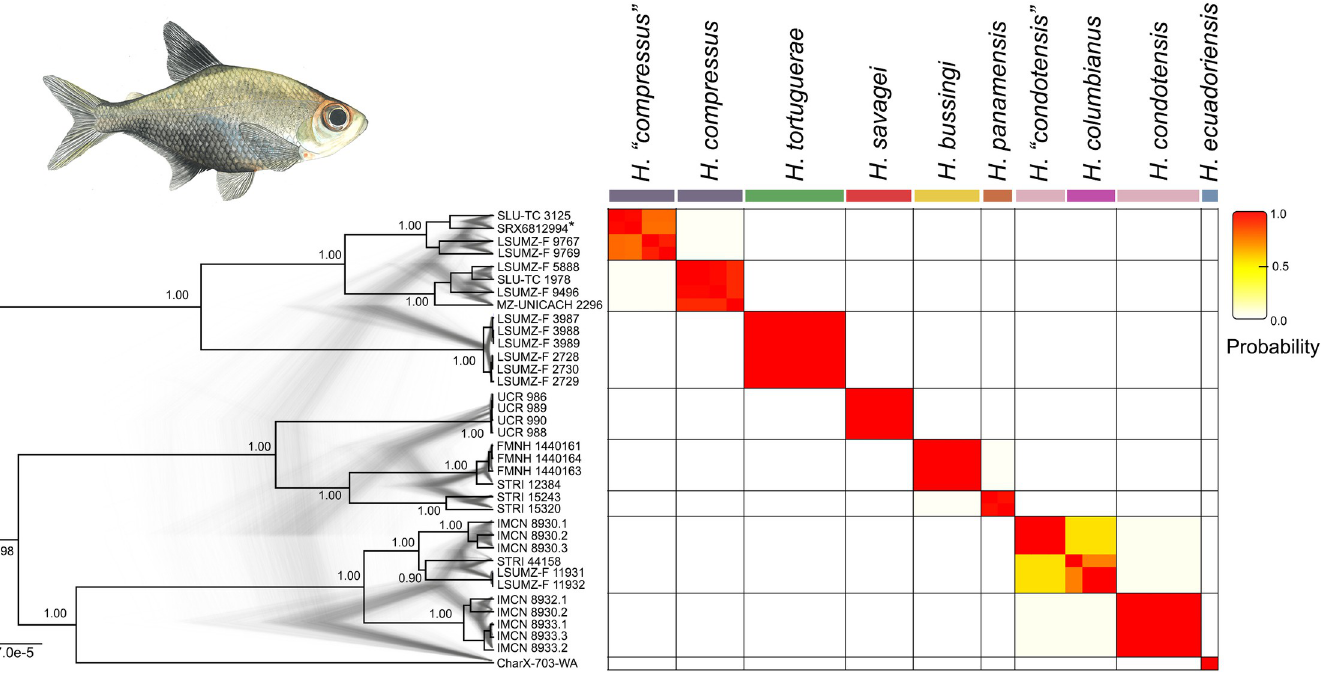
Fig 5. Assignment probability matrix from STACEY delimitation analysis. Each cell in the matrix shows the posterior probability of a pair of samples to belong to the same species cluster. Tip labels show the catalog number of the samples analyzed in the reduced dataset; asterisks indicate sample from Melo et al. [9] (See S1 Table). Darker colors indicate higher probability and lighter colors lower probability. The unrooted minimum species cluster tree (MSC-Tree) of trans -Andean Hyphessobrycon is shown to the left with posterior probabilities on the nodes. The posterior distribution of trees from the STACEY analysis is superimposed on the MSC-Tree. Illustration of male Hyphessobrycon compressus by Duangsamorn Boonwun